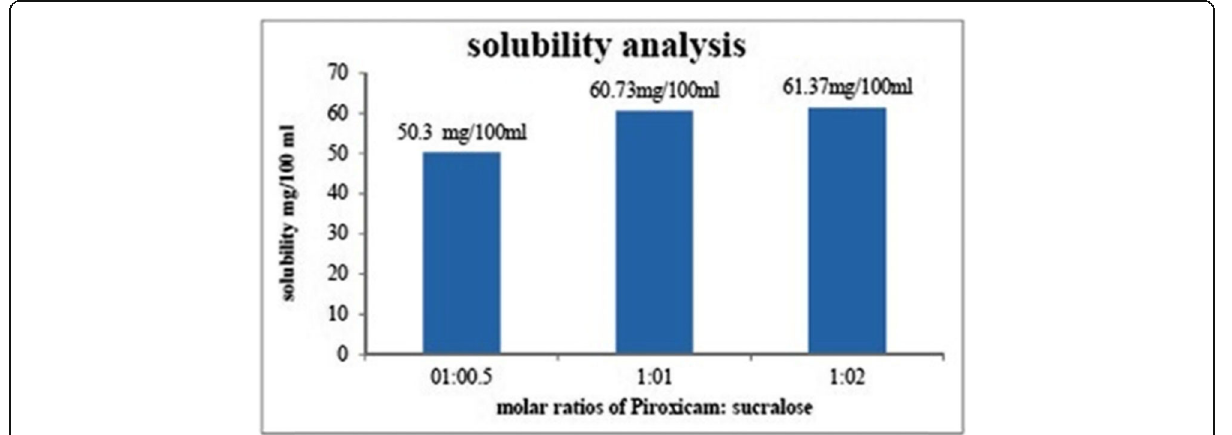
Fig. 4 Results of solubility studies of piroxicam-sucralose co-crystals